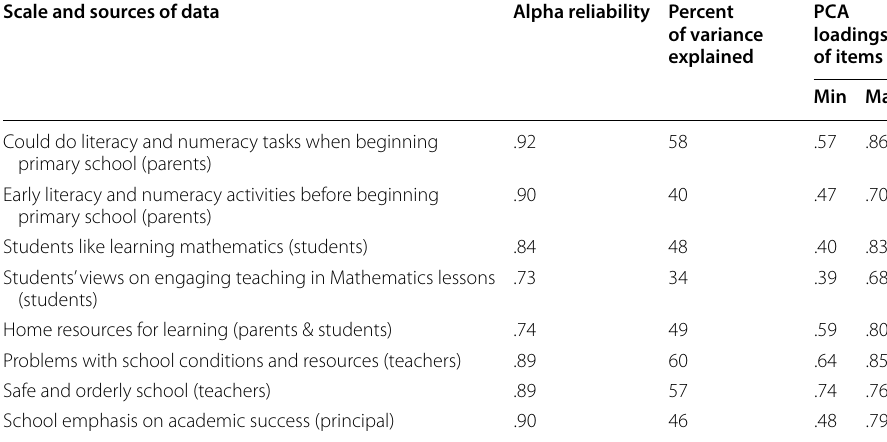
Table 1 Principle components analysis results and coefficient alpha of study scales Scale and sources of